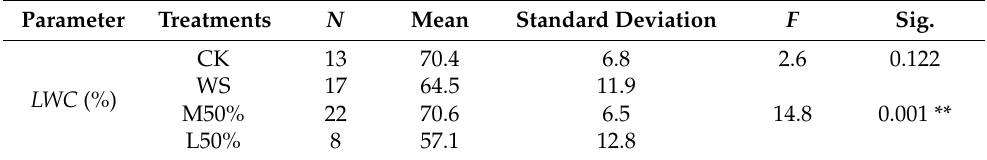
Figure 5. Dynamics of leaf water content of spring wheat under different relative soil moistures. CK refers to the control group. WS refers to the continuous drought group. The grey dashed line is the reference line of 50% relative soil moisture. Table 3. One-way ANOVA of leaf water content of spring wheat under different soil water treatments.